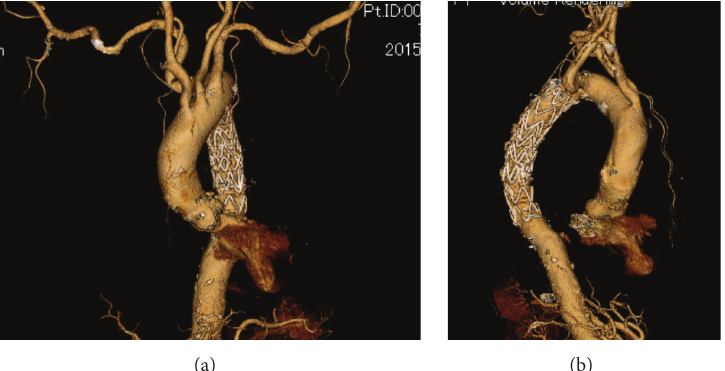
Figure 4: Three-dimensional CT findings at postoperative day 12. (a) Anterior view. (b) Right lateral view. The disappearance of ULP was confirmed by contrast-enhanced CT, and no endoleaks were observed. The stent grafts were placed distal to the origin of the right subclavian artery so the tips of the bare stents did not come into contact with the aortic